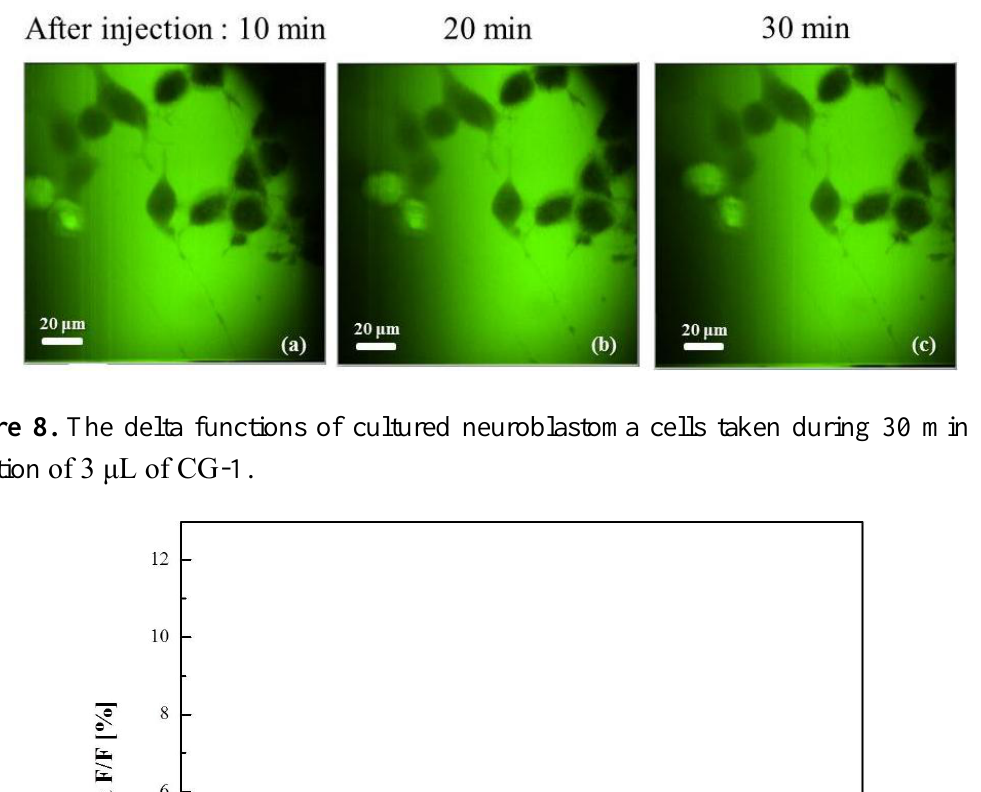
Figure 7. Consecutive fluorescence images taken 10, 20, 30 min after injection of 3 μL of CG-1 to cultured neuroblastoma cells.